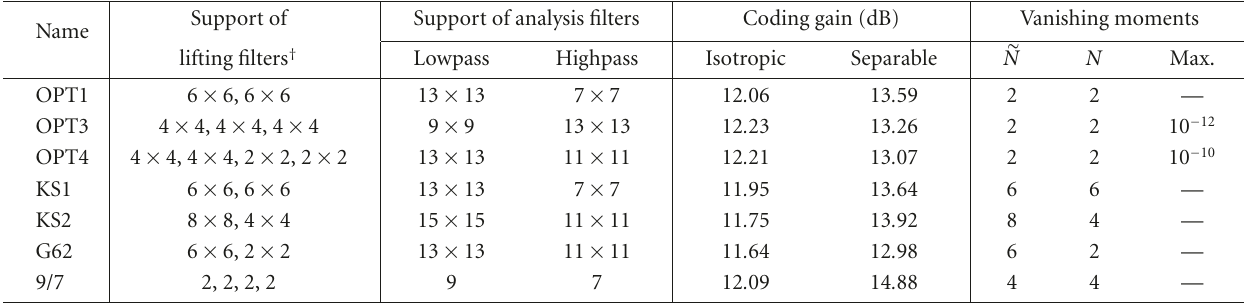
Table 3: Comparison of filter-bank characteristics.